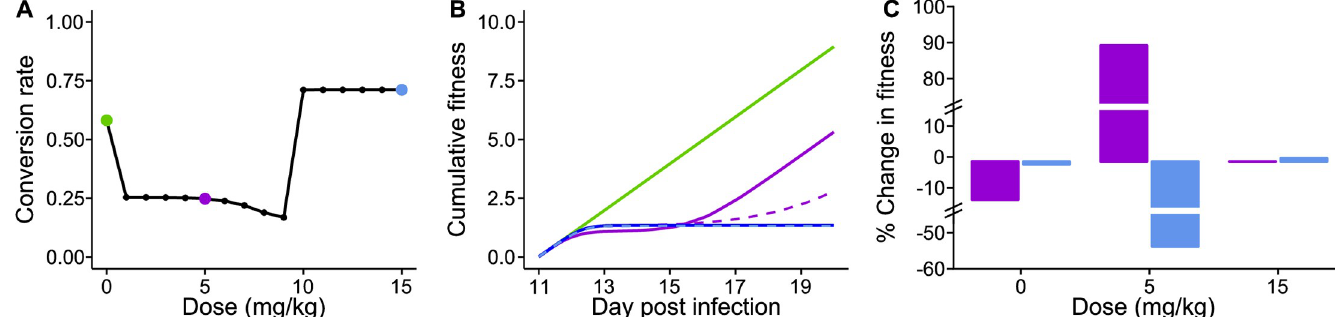
Fig 2. Conversion rate is adaptively adjusted in silico in response to a loss of state in a non-linear manner. Predicted optimal strategies and their fitness consequences across drug doses that reduce parasite state; strategies highlighted for untreated infections (green: 0 mg/kg), low dose (purple: 5 mg/kg) and high dose (blue: 15 mg/kg) drug treatment. ( A ) Compared to untreated infections, parasites should reduce conversion in response to low doses (reproductive restraint) but increase conversion in response to high doses (terminal investment). ( B ) Fitness, measured as cumulative transmission potential post-drug treatment, is highest in untreated infections (green) and reduced by drug treatment (purple and blue). Altering conversion rates allows parasites to partially compensate for the fitness costs of drugs. When treated with a low dose, reproductive restraint (solid purple line) allows parasites to recover to the same rate of transmission as untreated infections (as indicated by the slope of the solid green and purple lines) within 6 days. This also yields greater fitness than if parasites do not adjust conversion and follow the optimal strategy for untreated infections (dashed purple line). Although too small to visualise due to the scale of y-axis, changing conversion in response to a high dose yields a 1% fitness benefit (solid blue line) compared to parasites that do not adjust conversion and follow the optimal strategy for untreated infections (dashed blue line). (C) Optimal strategies are dose-specific. Fitness is calculated for parasites that follow the optimal strategies for low (purple) or high (blue) doses in each of the untreated, low dose, and high dose environments, relative to the optimal strategy for untreated infections. Adopting reproductive restraint (purple) or terminal investment (blue) costs fitness in untreated infections. At low doses, reproductive restraint (purple) is the optimal strategy and terminal investment is the poorest strategy. At high doses, terminal investment (blue) is marginally better than reproductive restraint